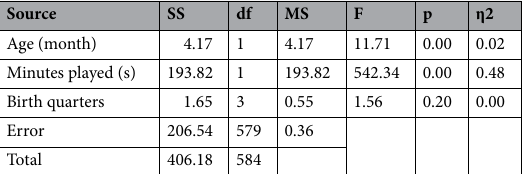
Table 4. Covariance analysis for efficiency rating by birth quarters.